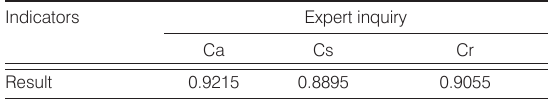
Table 2. Expert authority coefficient. Table 3. Reliability-testing statistics ( N = 681).